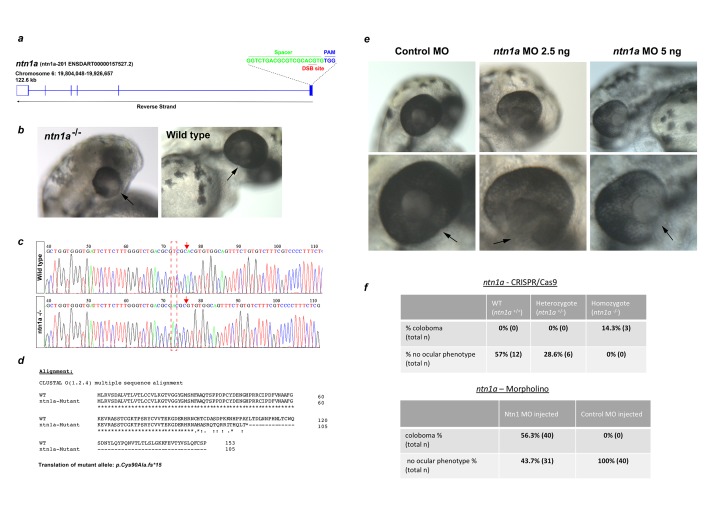
Gross ocular phenotype analyses of ntn1-deficient zebrafish.(a) Gene-editing strategy using a single sgRNA targeting the first exon of zebrafish ntn1a. CRISPR/Cas9 was used to generate heterozygous (ntn1+/-; G0) founders. These were crossed to generate homozygous G1 embryos (ntn1-/-). (b) Panels showing the coloboma microphthalmia and coloboma (arrow) phenotypes in gene-edited ntn1-/- embryos compared to wild-type. (c) Sanger sequencing confirmed the homozygous gene-edited ntn1a allele in 100% of phenotypic G1 embryos. (d) In silico translation of encoded mutant allele aligned to wild-type (first 153 amino acids shown of 603 aa ntn1a protein are shown). The gene edited mutation encodes a frame-shift in the first exon resulting in a truncated ntn1a of 105 amino acids (p.Cys90Ala.fs15). (e) Morpholino experiments produced bilateral coloboma in 100% of embryos injected with ntn1a translation-blocking MO, with no ocular phenotypes observed in control MO injected embryos. The optic fissures are indicated by arrows. (f) Tables with penetrance of colobomas in gene-edited embryos and MO embryos compared to controls.